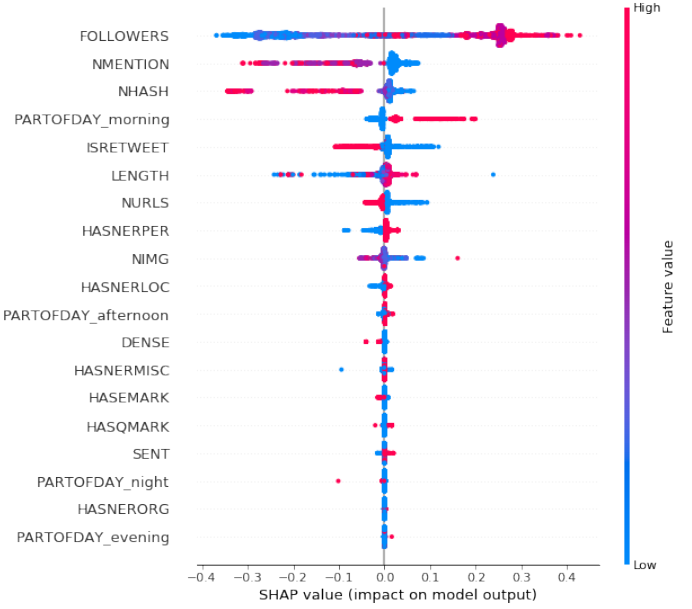
Figure 3. An example of interpretable machine learning result in the context of the Social Network Analytics